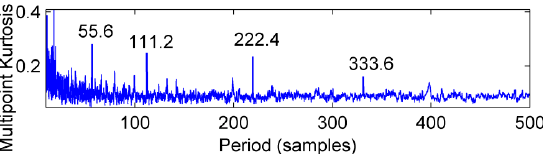
Figure 23. CPF 2 multi-point kurtosis spectrum.